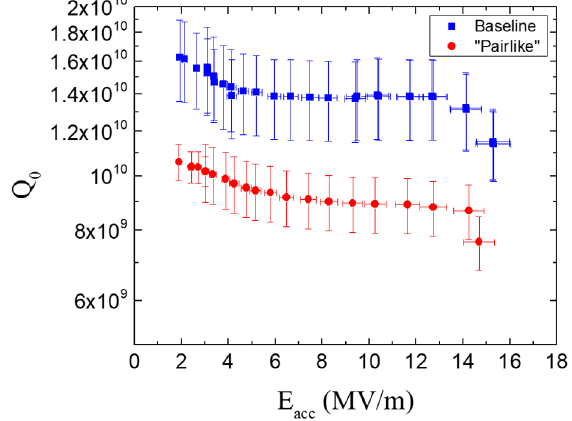
FIG. 9. VTA test results at 2.0 K for C50 cavity IA366 assembled in two configurations, i.e., without a dogleg and cold window (baseline) and with a dogleg and cold window ( “ pair- like ”